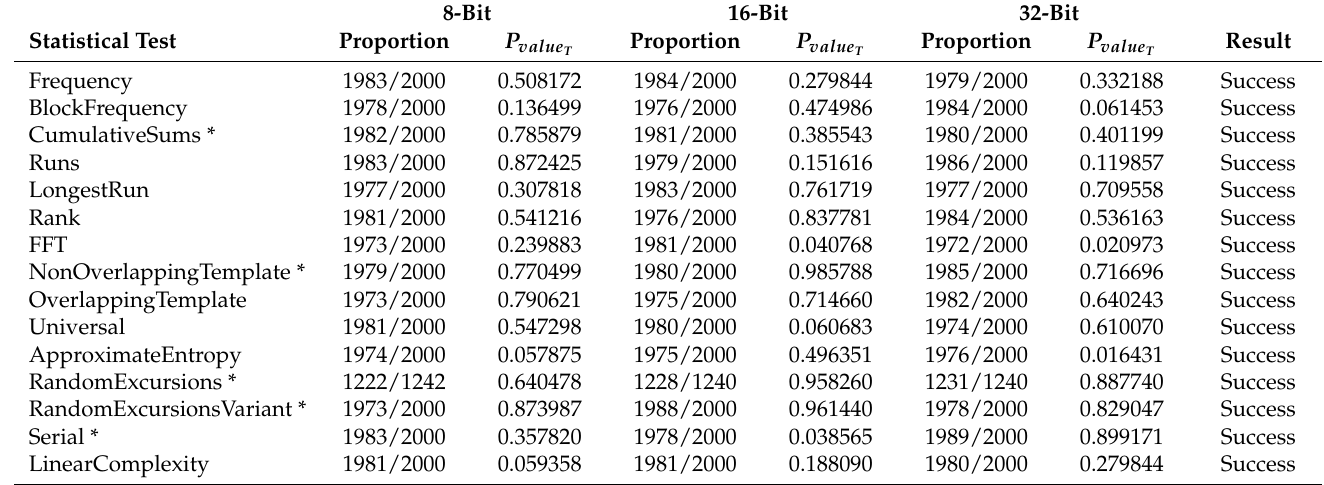
Table 3. Results of pseudorandomness tests applying the NIST SP 800-22 suite to 2000 binary sequences with a 1,000,000- bit